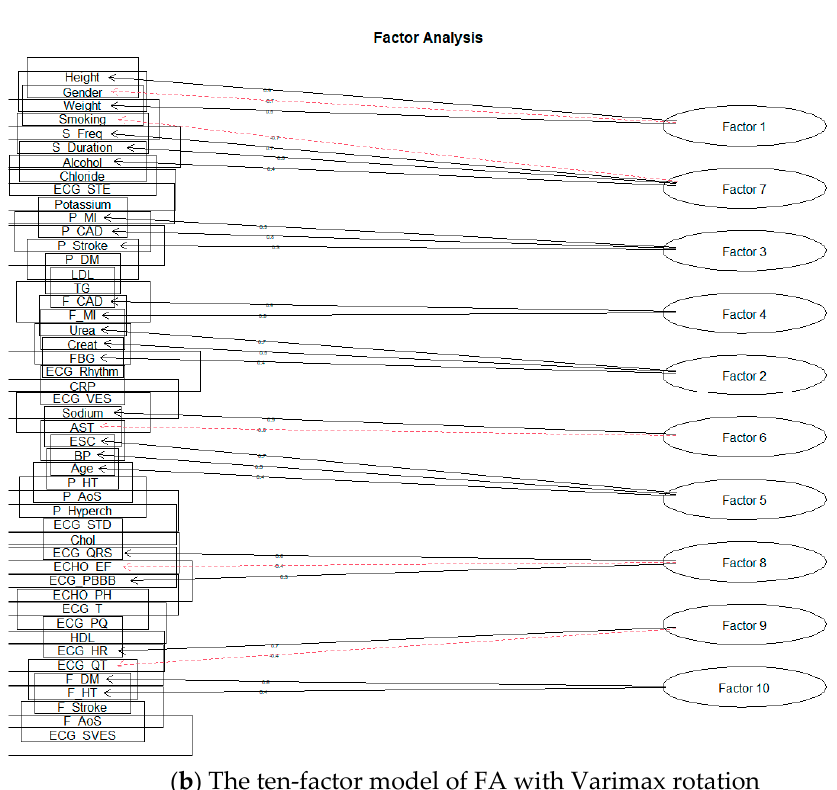
Figure 8. The solution of FA for Varimax rotation.